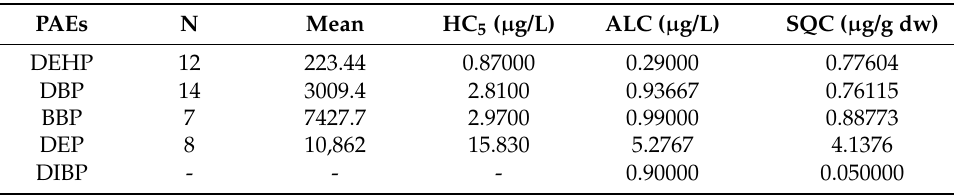
Table 1. Parameters of SSDs for four PAEs (exclude